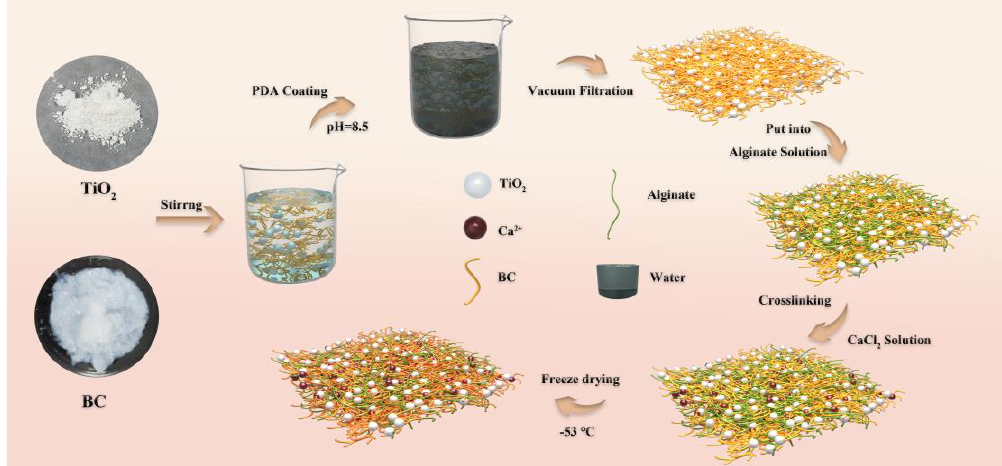
Scheme 1. Synthesis path diagram of